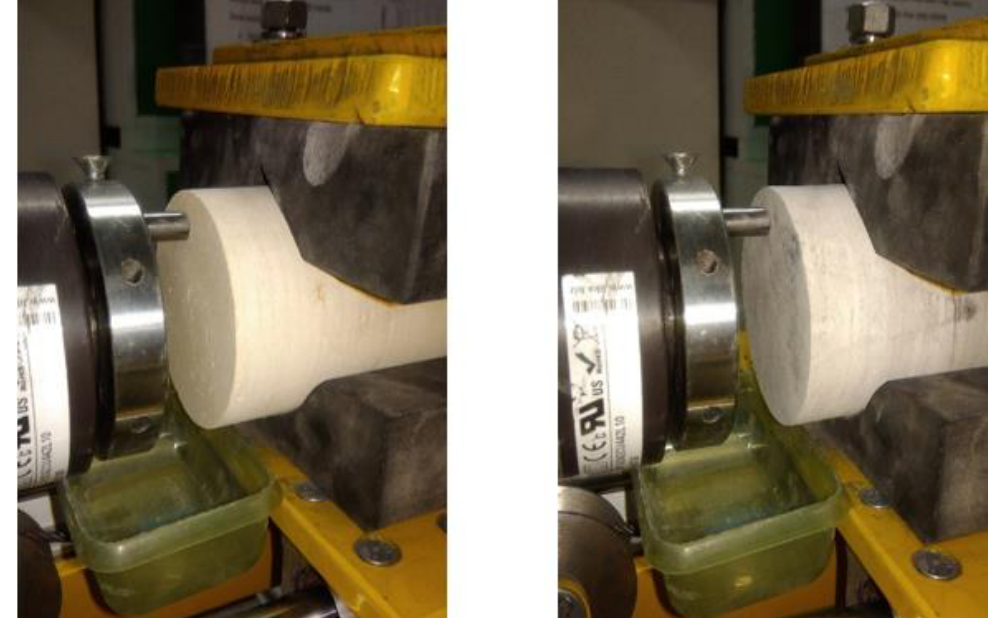
Figure 5. View of selected sandstone samples during the abrasivity test.